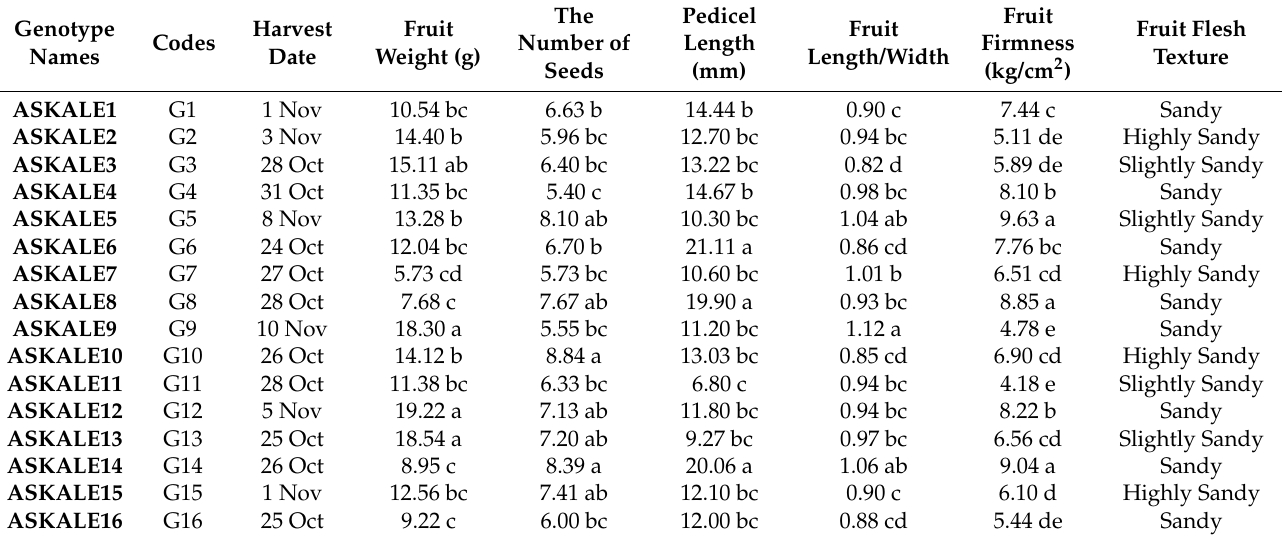
Table 1. Phenological and morphological characteristics of Pyrus elaeagrifolia Pall. subsp. elaeagrifolia